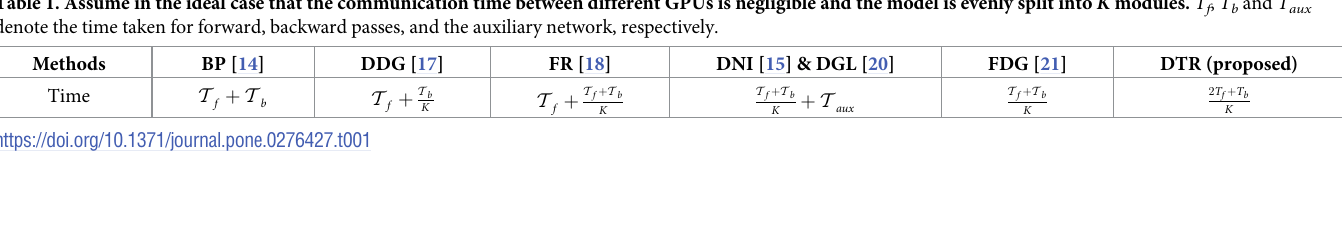
, T and T f b aux